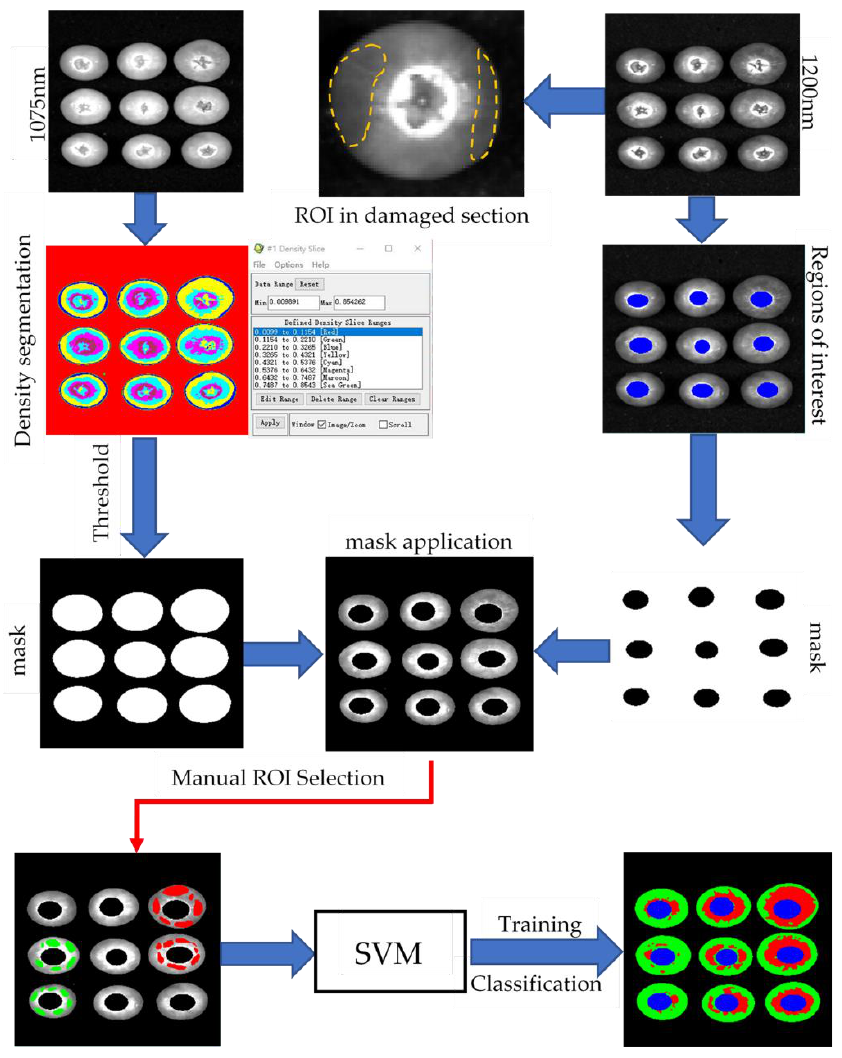
Figure 3. Hyperspectral image processing process of blueberries.